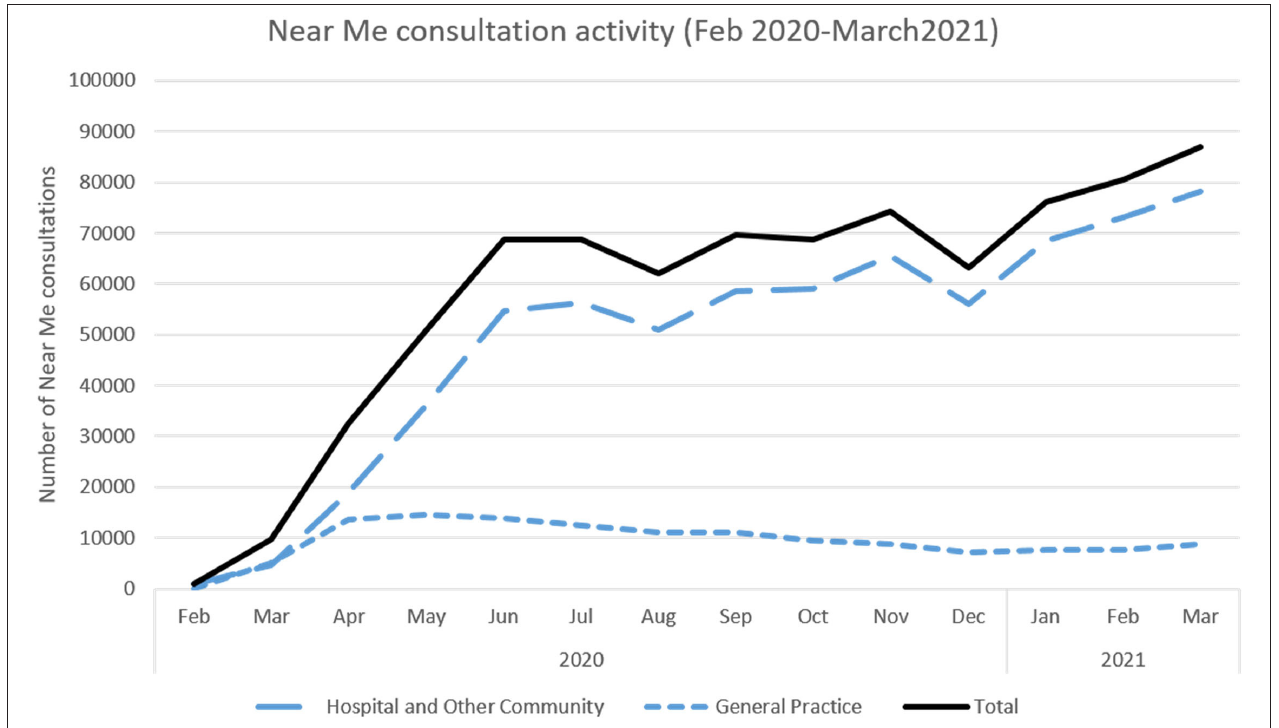
FIGURE 2 | Growth of video consultations before and during the pandemic. Graph shows total number of video consultations for GP, hospital and other community services, February 2020 to March